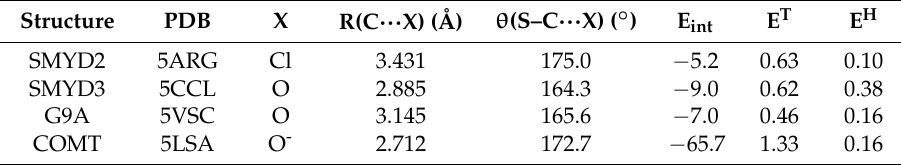
Table 2. Properties of tetrel bond in indicated systems, where X indicates nature of electron donor atom. Energetics are reported in